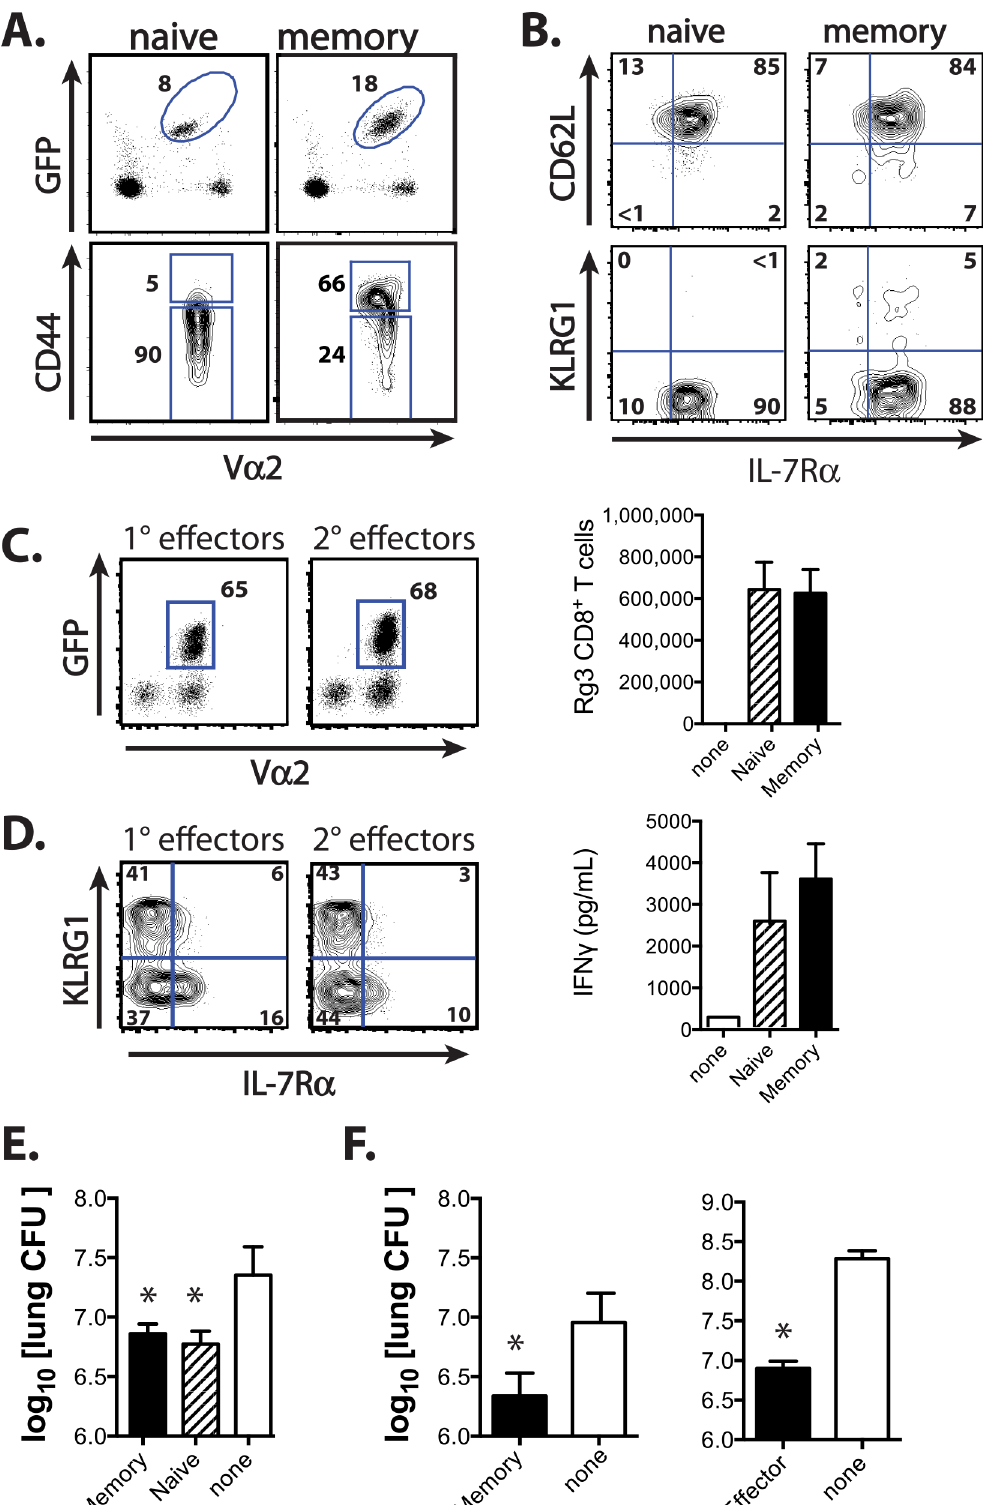
Fig 3. TCR retrogenic TB10-specific CD8 + T cells allow direct comparison of the 1° and 2° responses during infection. (a) The proportion of TB10Rg3 cells (%GFP + V α 2 + ) among CD8 + T cells and their CD44 expression, 8w after vaccination of TCR Rg mice (memory) or age-matched unvaccinated TCR